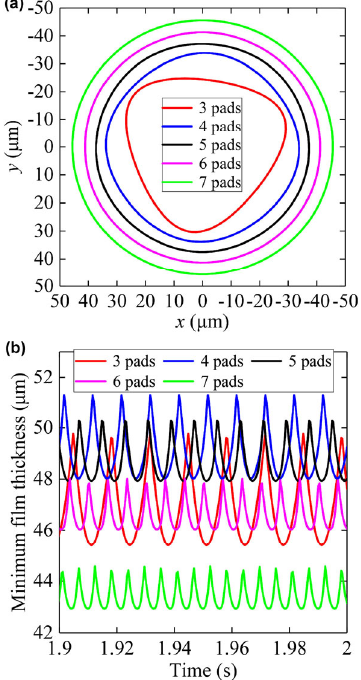
Fig. 19 (a) Journal center orbits and (b) dynamic minimum film thicknesses of a TPJB with static loads for different numbers of